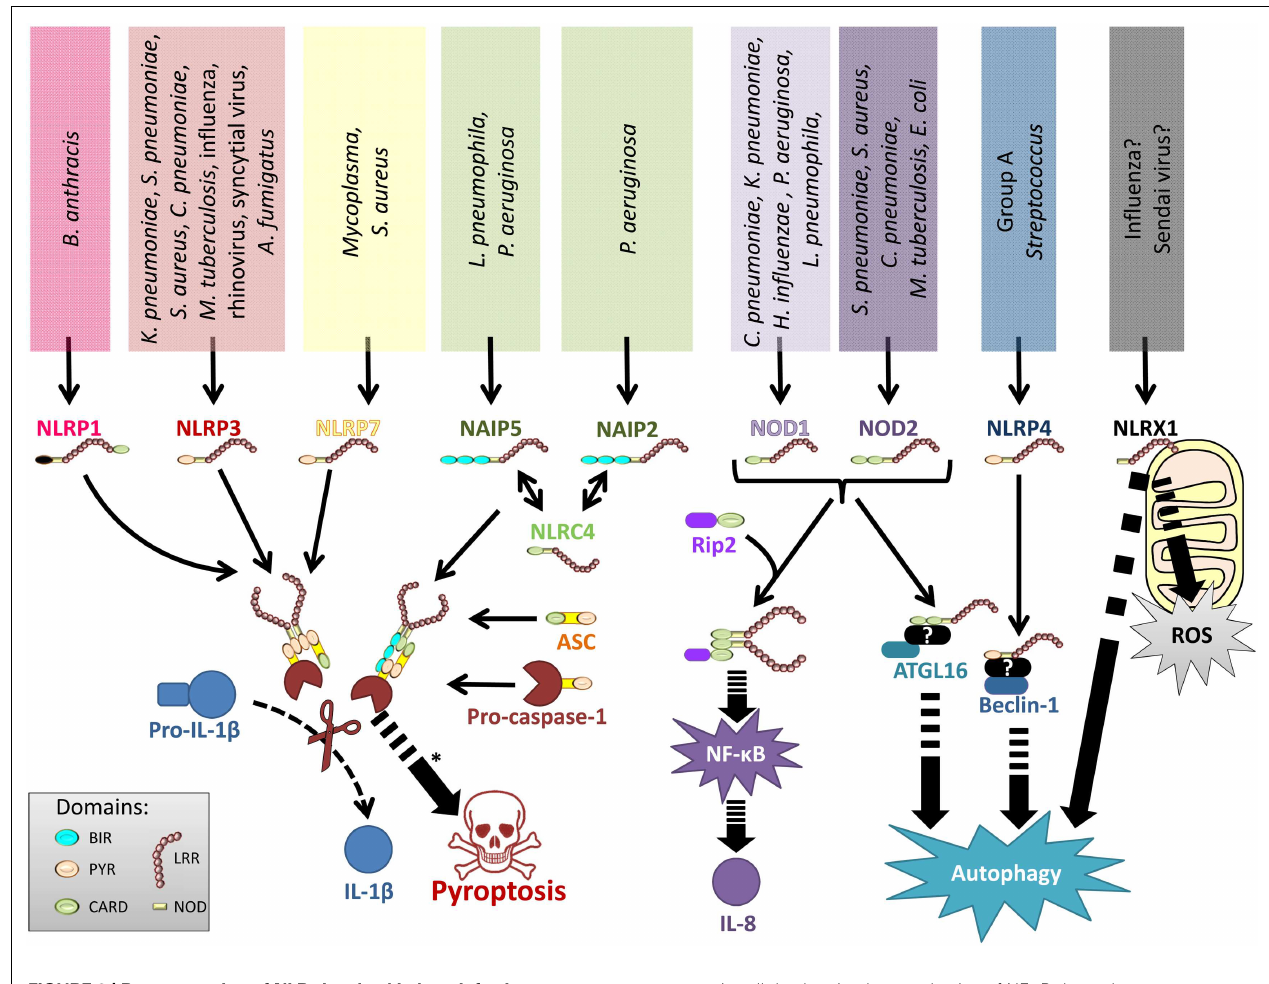
FIGURE 2 | Representation of NLRs involved in lung infections . Various lung pathogens can be sensed by different NLR.These NLRs either form inflammasomes to regulate IL-1 family cytokines and